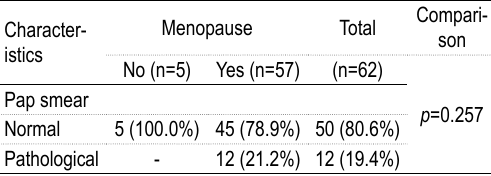
Table 1. Menopause and Pap tests ratio